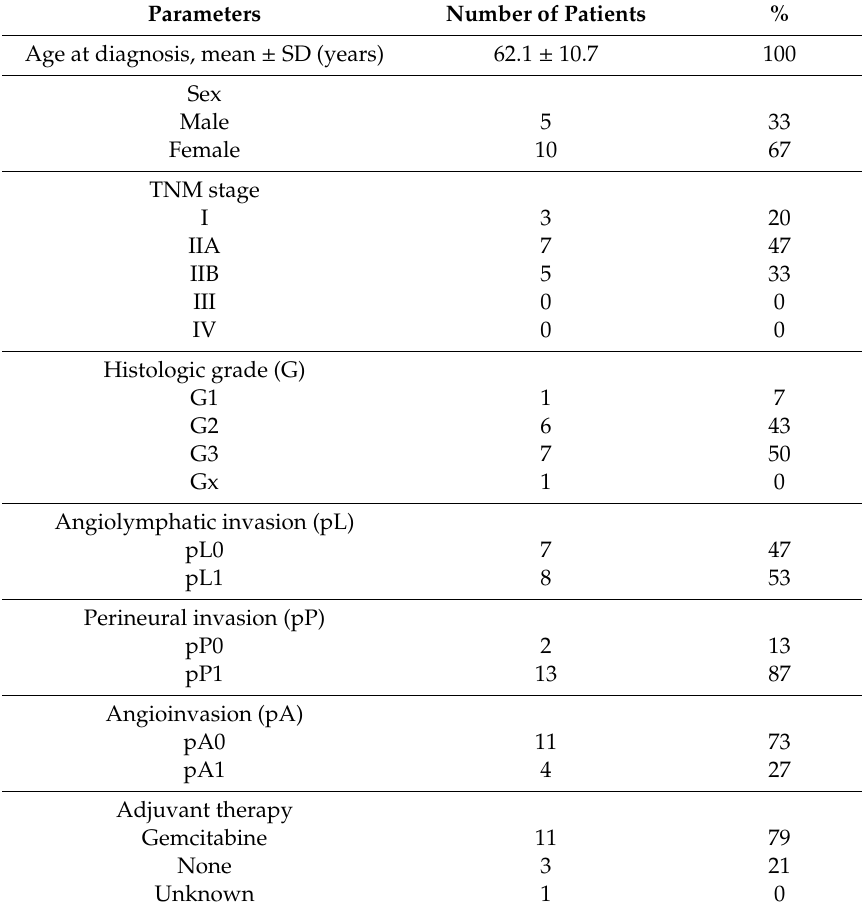
Table 1. Clinical characteristics of the